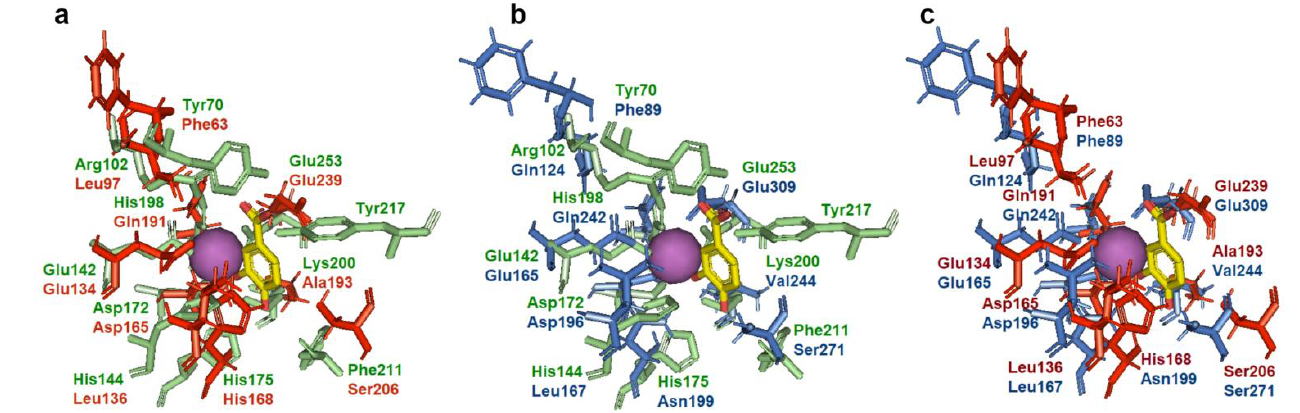
Figure 8. Pairwise active site superimposition of AsbF, QsuB, and Qa-4. 3,4-DHBA and Mn 2+ were modeled in from the AsbF crystal structure (PDB ID: 3DX5) and is depicted in yellow and as purple sphere, respectively. The residues in green, blue, and red correspond to AsbF, Qa-4, and QsuB, respectively. AsbF crystal structure (PDB ID: 3DX5) and 3D models of QsuB and Qa-4 were used. ( a ) AsbF and QsuB, ( b ) AsbF and Qa-4, ( c ) QsuB and Qa-4.